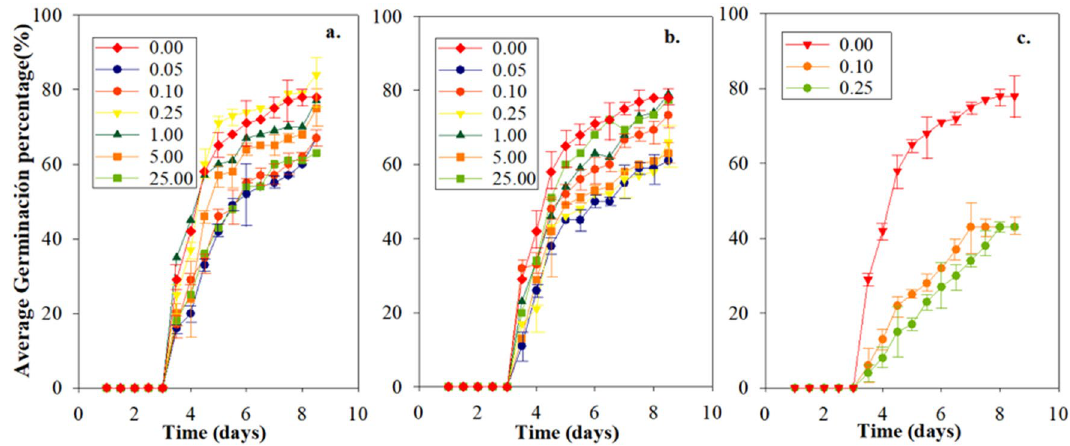
Figure 2. Germination percentages of L. perenne exposed to de different metal concentrations. ( a ) Cd 2+ , ( b ) Hg 2+ , ( c ) Cd 2+ –Hg 2+